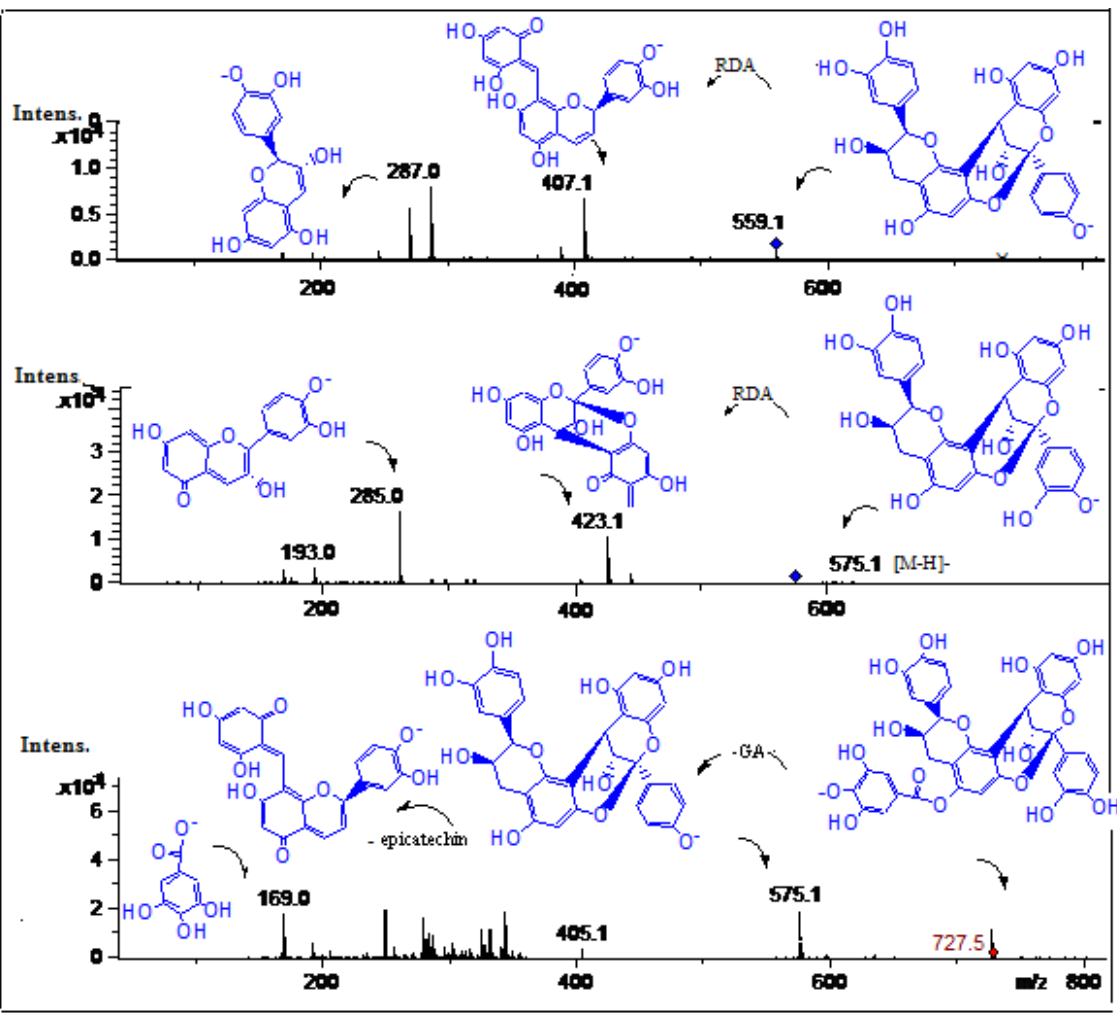
Figure 10. Structures, fragmentation, full ESI-MS and MS-MS spectra of peaks 6 , 7 , and 9